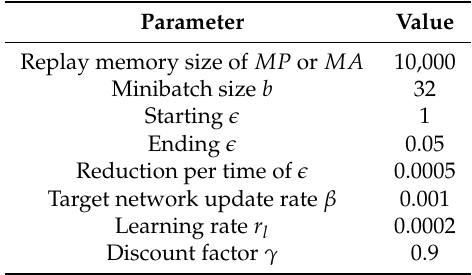
Table 3. Parameters in Double Deep Q-Network with